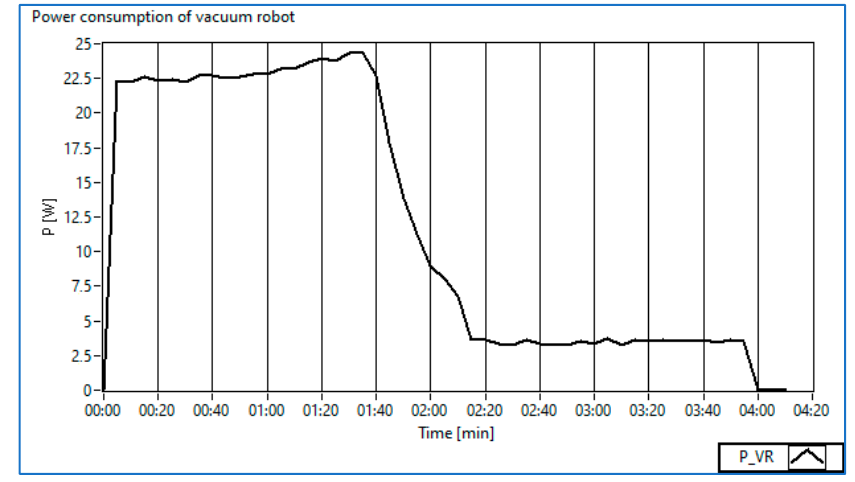
Figure 4. Power consumption (P_VR) during an operation cycle for robot vacuum.